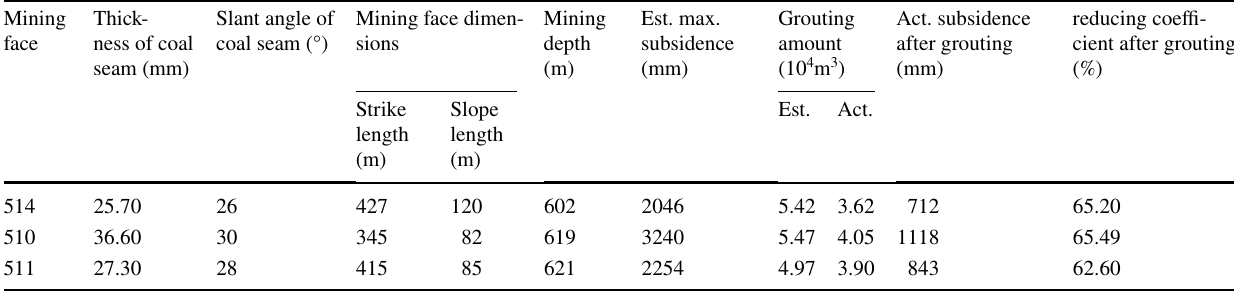
Mining face dimen- sions